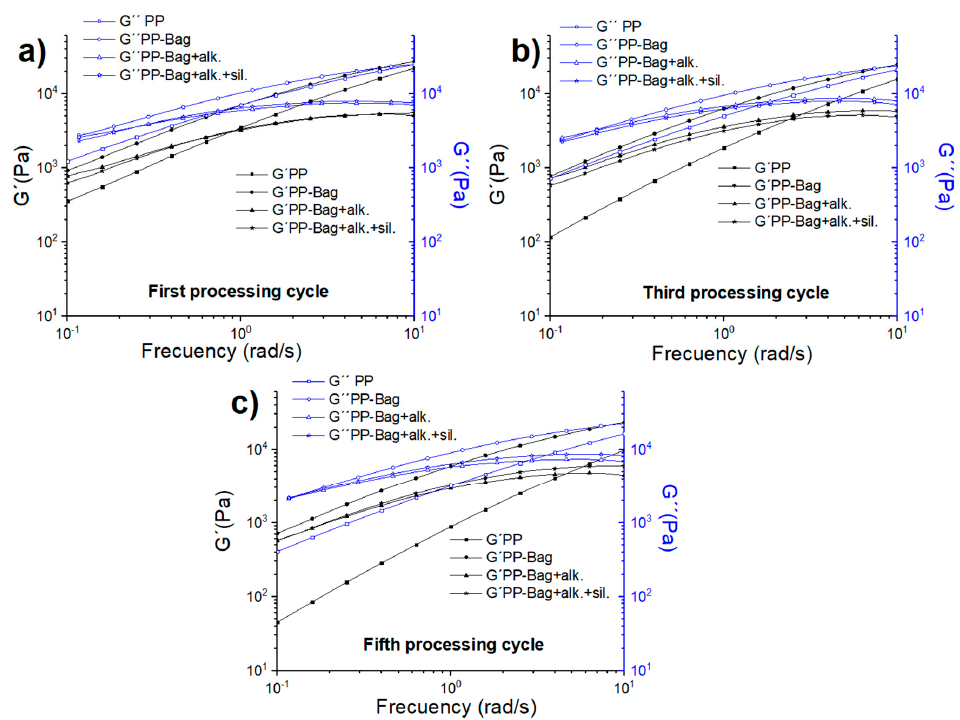
Figure 10. Storage and loss modulus as a frequency function of PP and PP-Bagasse biocomposites: ( a ) First, ( b ) Third and ( c ) Fifth processing cycles.